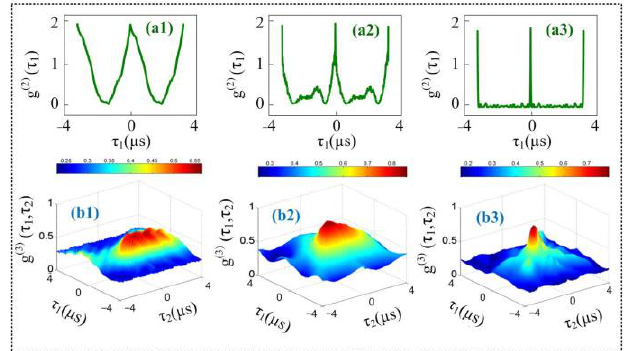
Figure 3. ( a ) Measured second-order temporal correlation of two pseudo-thermal sources plotted by changing the power of E 1 ( P E 1 ) by fixing t 1 time offset at 0 μs ; ( a1 ) P E 1 = 1 mW; ( a2 ) P E 1 = 3 mW; ( a3 ) P E 1 = 5 mW; ( b ) The third-order temporal correlation of two pseudo-thermal sources by changing the power of E 1 ( P E 1 ); ( b1 ) P E 1 = 1 mW; ( b2 ) P E 1 = 3 mW; ( b3 ) P E 1 = 5